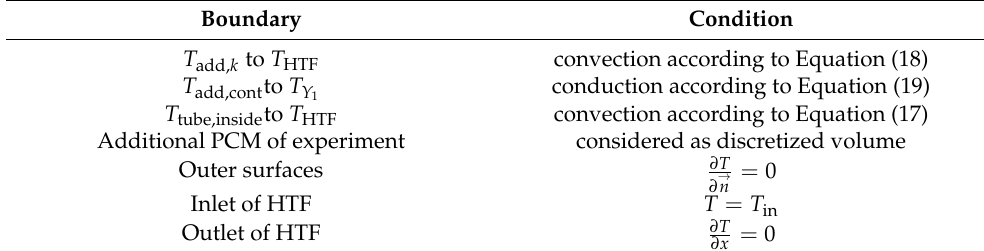
Table 5. Overview of boundary conditions.